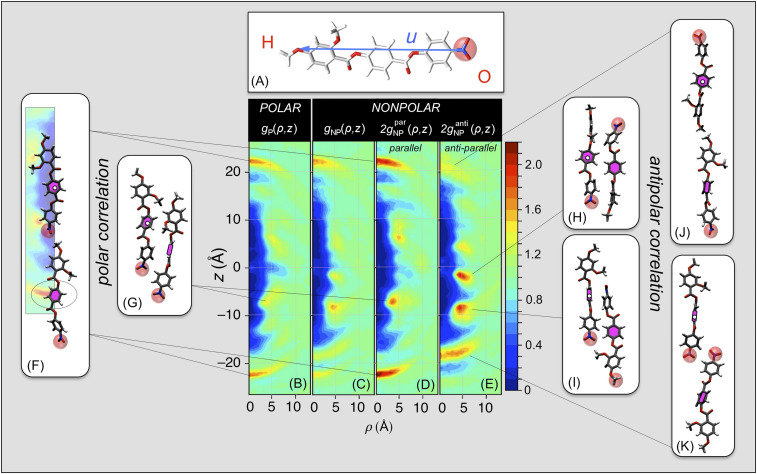
 Results of atomistic molecular dynamic simulations probing molecular-scale organization leading to polar order. (A) RM734, showing its geometrical long axis vector u, terminating at the nitro- (O) and methoxy (H) molecular ends. A nanoscale volume containing 384 molecules is equilibrated into two distinct LC states: a POLAR system with all polar molecular long axes, u, along +z and a NONPOLAR system with half along +z and half along −z. Equilibration of the molecular conformation and packing is readily achieved, but end-to-end flips are rare, so the simulated states remain in the polar or nonpolar limit of equilibrated nematic order. (B–E) Molecular positional/orientational pair correlation functions: conditional probabilities of molecular centers (magenta), about centers fixed at the origin (white dots). (B, F, and G) The POL simulation shows directly the dominant pair correlations adopted by molecules that are polar ordered, in the form of conditional probability densities, g(ρ,z), of molecular centers (magenta fill) around a molecule with its center (white dots) at the origin and long axis u along z. The g(ρ,z) are 𝜑-averaged to be uniaxially symmetric, reflecting the uniaxial symmetry of the N and NF phases. They exhibit a molecule-shaped, low-density region [g(ρ,z) ∼0] around the origin resulting from the steric overlap exclusion of the molecules; an asymptotic constant value at large ρ giving the normalized average density [g(ρ,z) = 1]; and distinct peaks indicating preferred modes of molecular packing. This analysis reveals two principal preferred packing modes in the POL system: (B and F) polar head-to-tail association stabilized by the attraction of the terminal nitro and methoxy groups and (B and G) polar side-by-side association governed by group charges along the molecule, nitro-lateral methoxy attraction, and steric interactions of the lateral methoxys. (D and E) The NONPOL system exhibits distinct correlation functions for antiparallel and parallel molecular pairs, gNPanti(ρ,z) and gNPpar(ρ,z). (E, H, and I) The preferred antiparallel packing gives strong side-by-side correlations, governed by group charges along the molecule, and (E, J, and K) weaker antipolar nitro–nitro end-to-end association. (D, F, and G) The parallel correlations in the NONPOL system are the most relevant to the stability of polar order in the NF phase as they are determined by the inherent tendency of the molecular interactions for polar ordering in the presence of enforced polar disorder. Comparison of B and D shows identical preferred modes of parallel association in the two systems, with the POL system correlations being even stronger in the NONPOL system. This is clear evidence that the polar packing motifs giving the correlation functions (B) and (D), exemplified by the sample POL MD configurations (F) and (G), stabilize the polar order of the ferroelectric nematic phase.